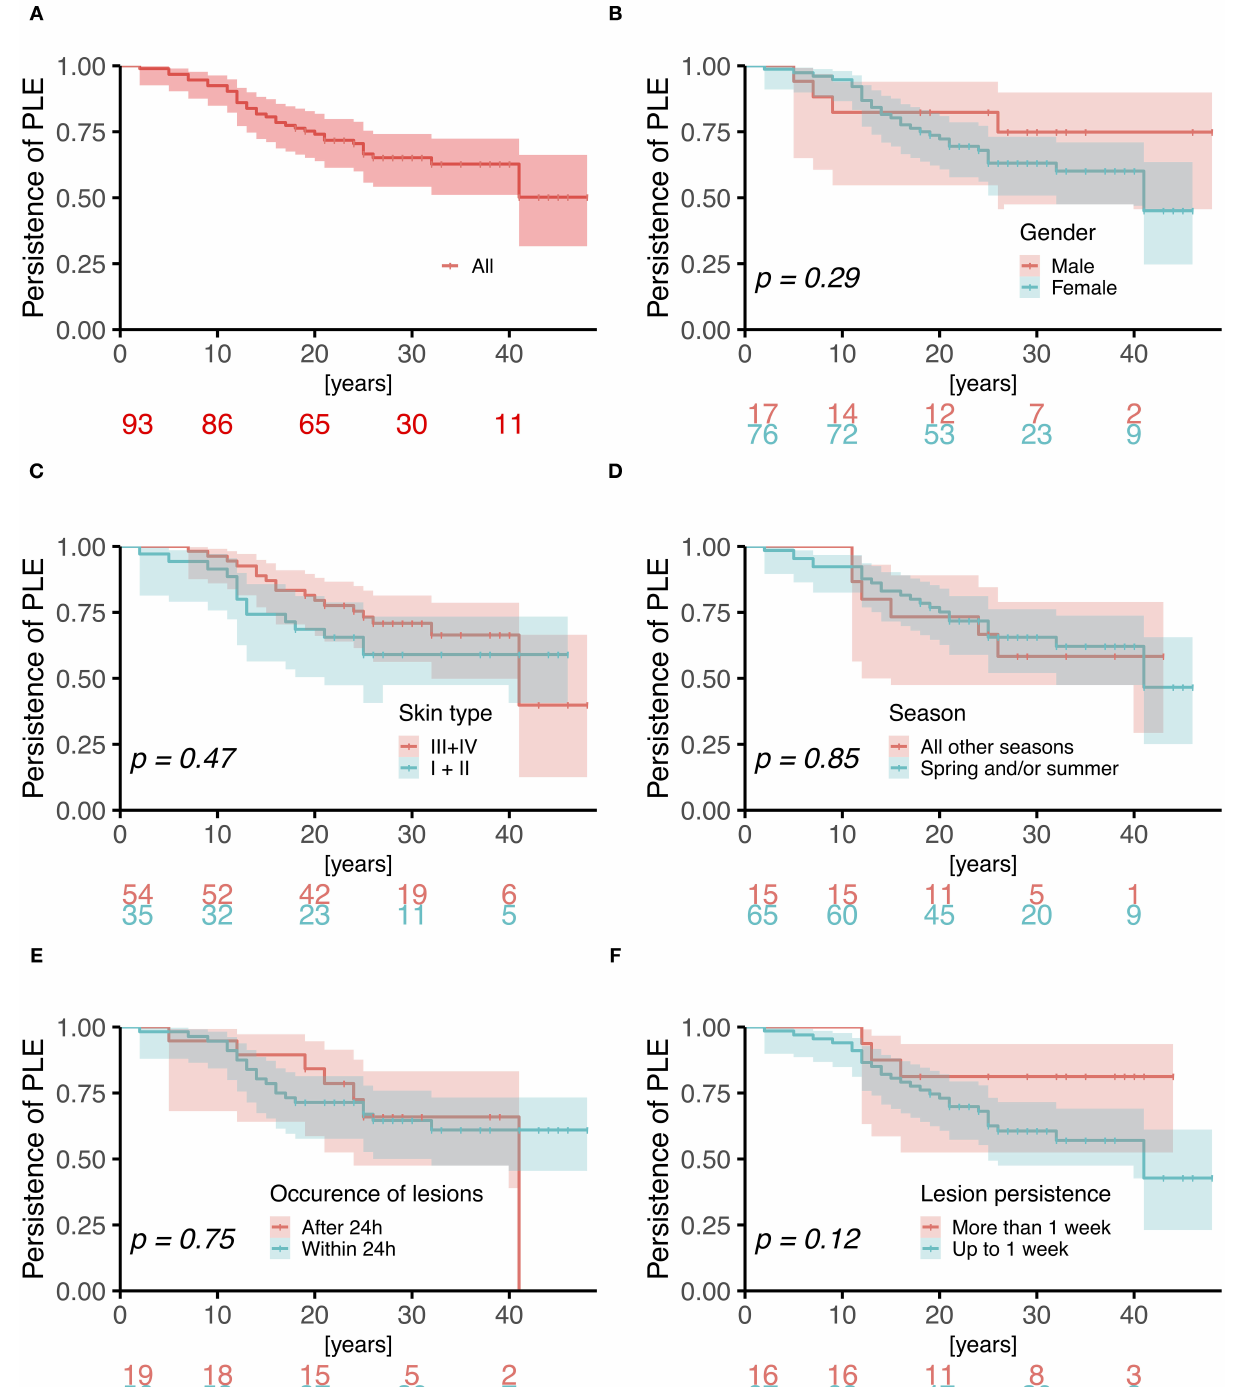
Frontiers in Medicine |